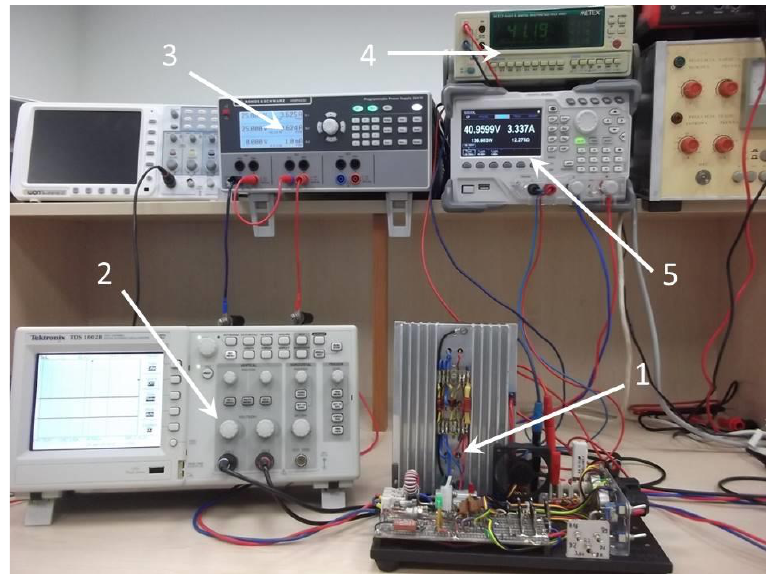
Figure 8. General view of the measuring stand: 1 — PVE prototype (under testing), 2 — two-channel digital oscilloscope, 3 — programmable DC supplier, 4 — digital multimeter, 5 — programmable elec- tronic load.